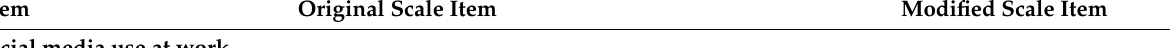
Table A1. Research